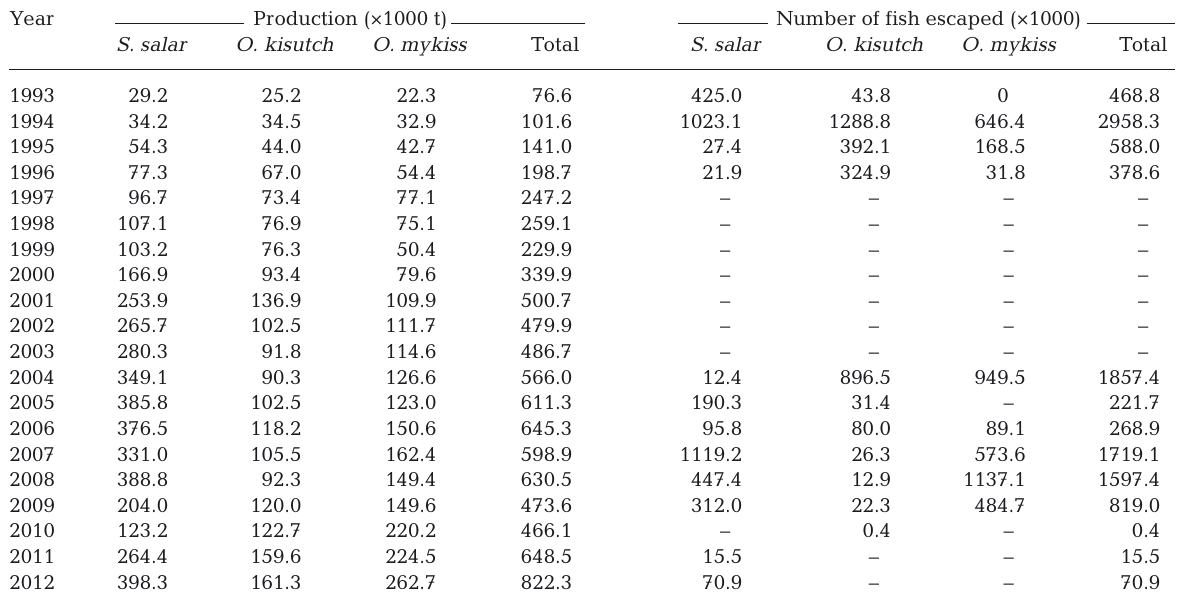
Table 1. Salmo salar , Oncorhynchus kisutch , and O. mykiss . Total salmonid production and reported escapes by species from 1993 to 2012. Escape data for 1993 to 1996 from Soto et al. (1997) and for 2004 to 2012 from the National Fisheries